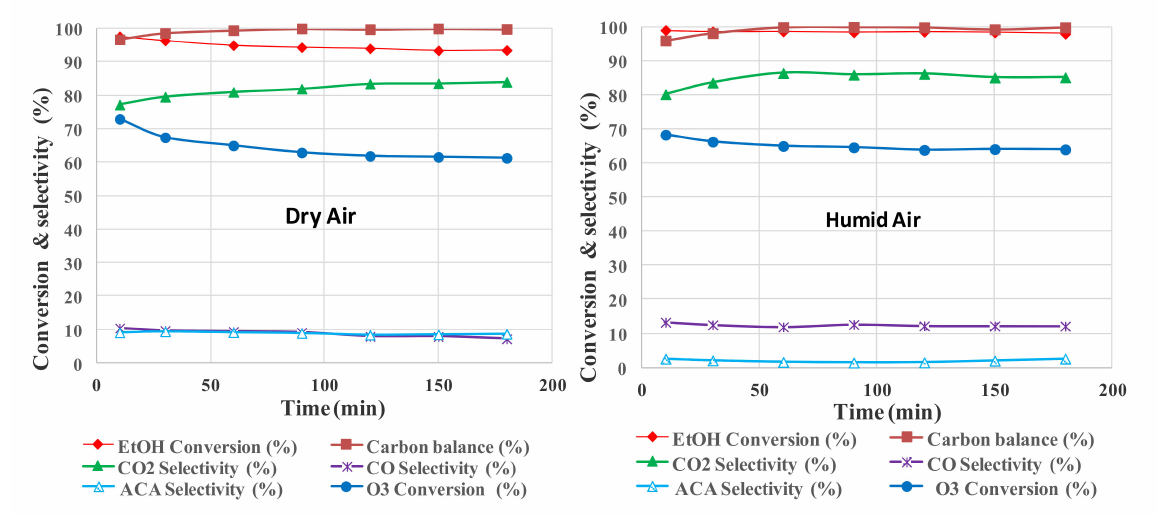
Figure 4. Ethanol conversion, ozone conversion, products selectivity and carbon balance as a func- tion of time on stream in dry ( left ) and humid ( right ) conditions (catalyst = 20 mg, total flow rate = 500 mL · min − 1 , [EtOH] = 10 ppm, [O 3 ] = 70 ppm, T = 60 ◦ C) for the 5Mn/TiO 2 mM catalyst calcined at 400 ◦